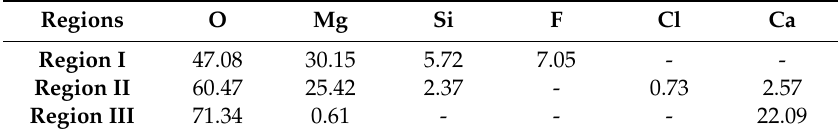
Figure 7. SEM surface morphologies and EDS results of MAO–Cu 2 P 2 O 7 coating after immersion test. Table 5. EDS results of the three layers of the MAO–Cu 2 P 2 O 7 coatings immersed in artificial seawater for 14 days (at. %).